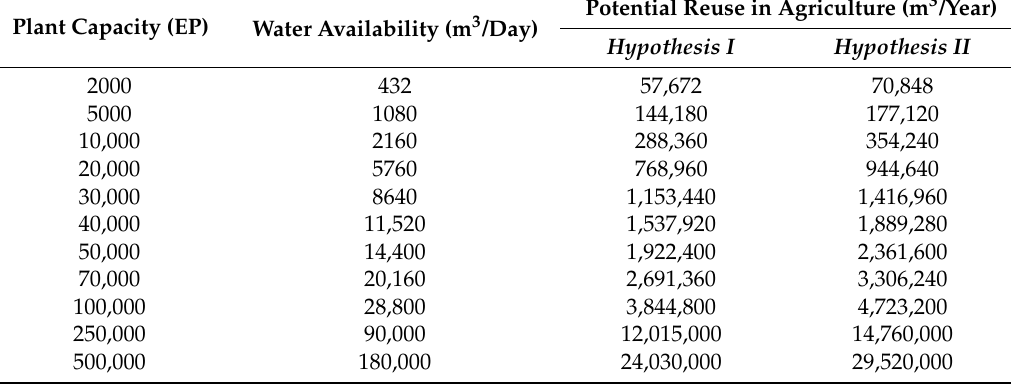
Table 5. Average water availability at plant